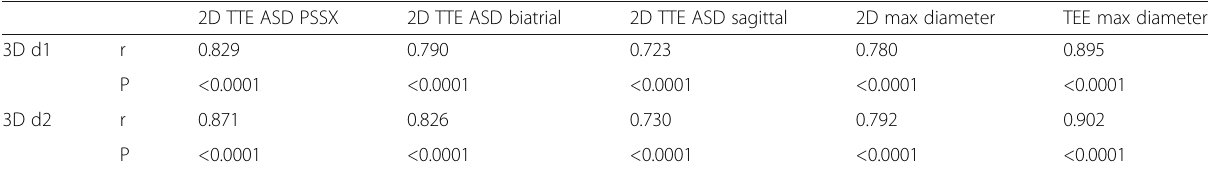
Table 3 correlation between maximum and minimum ASD diameter measured by 3D echocardiogram and diameters measured by 2D TTE and 2D TEE